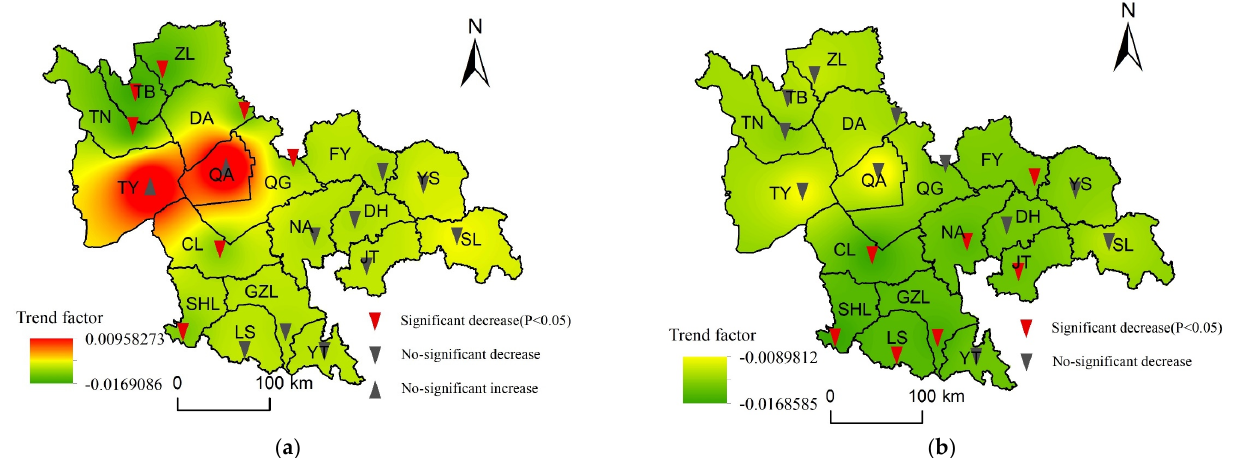
Figure 4. Seasonal trends of SPEI − 3 index in study area from 1955–2020: ( a ) spring; ( b ) summer.